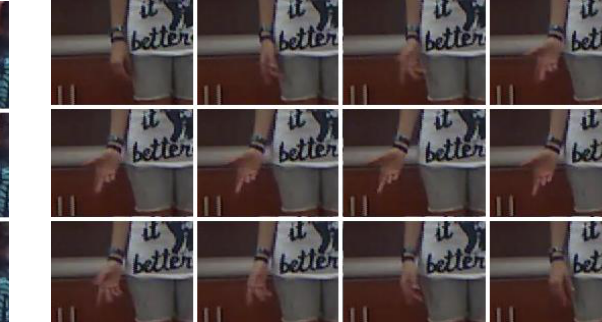
Figure 5. Sample00831, frames 921-1015